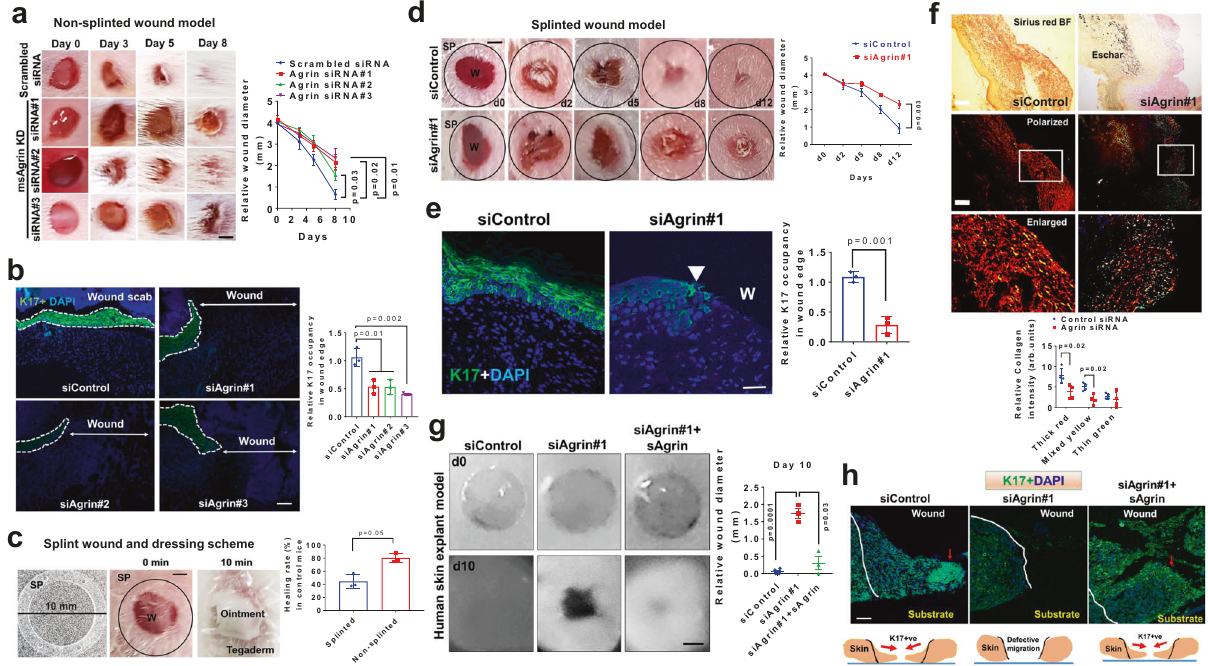
Fig. 2 Agrin depletion impairs skin wound healing. a Representative photographs of mouse wounds at the indicated days of treatment with siRNA containing ointments. Wound diameter presented as mean + / − s.e.m. ( n = 4 mice per group, Two-way ANOVA, * p = 0.02, 0.03 and 0.01, respectively) on indicated days post-wounding. Scale: 1 mm. b Confocal microscopy images showing K17 and DAPI staining at day 5 post-wounding in the mouse skin sections treated as in ( a ). Scale: 50 μ m. Relative K17 staining intensity represented as mean + / − s.d. ( n = 3 sections per group, Students ‘ t ’ test, two-tailed, p = 0.01, p = 0.002, respectively). c Photographs showing splinted wound dressing scheme. Wound diameter at day 7 in splinted and